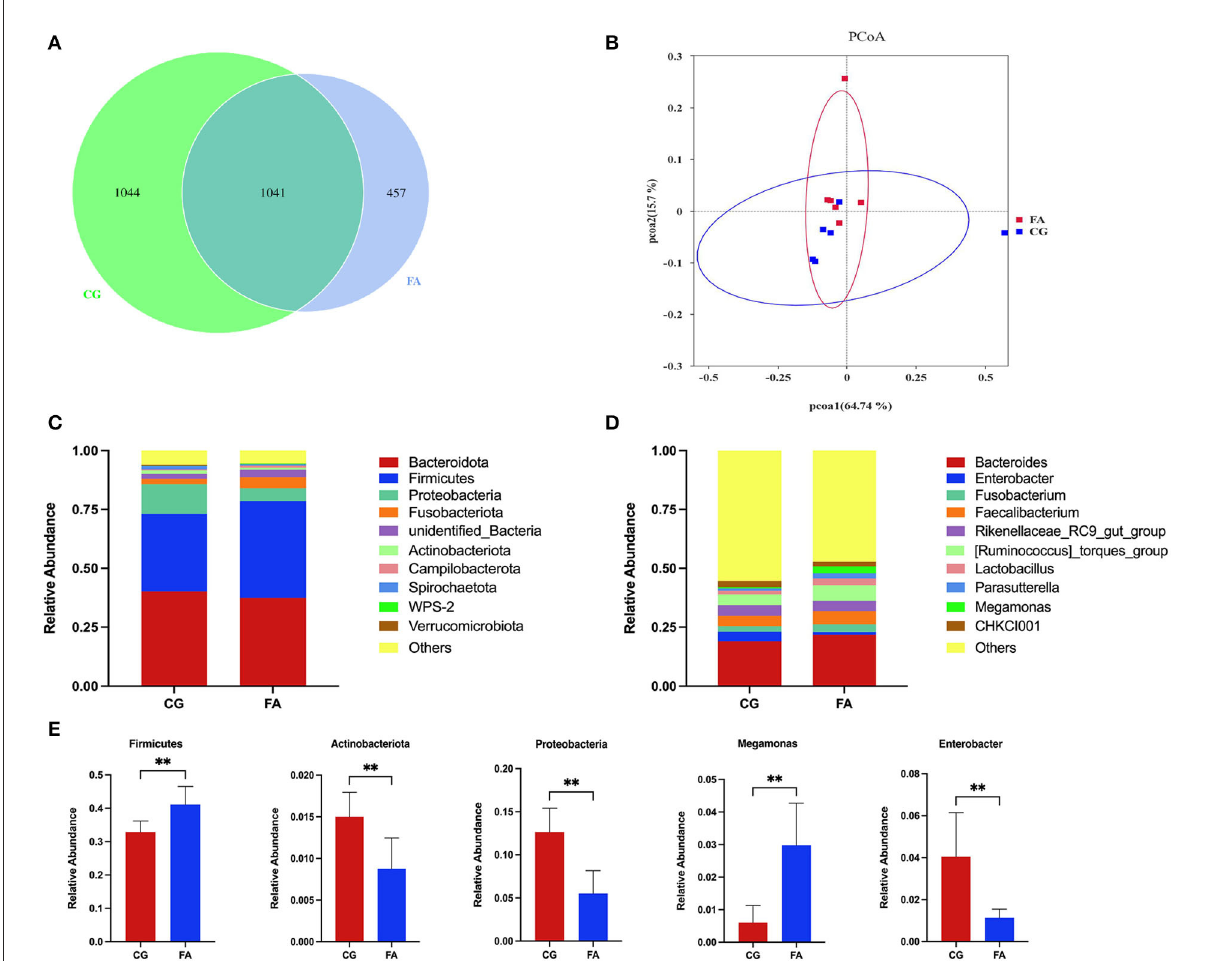
FIGURE1 Cecal contents microbial composition. (A) Venn diagram of OTUs number; (B) PCoA of the cecal microbiota; (C) Phylum-level taxonomic composition of the cecal microbiota; (D) Genus-level taxonomic composition of the cecal microbiota. (E) Relative abundance of Firmicutes , Actinobacteriota , Proteobacteria , Megamonas, and Enterobacter . CG, control group; FA, fulvic acid. Significant deviations are denoted by asterisks (** P <